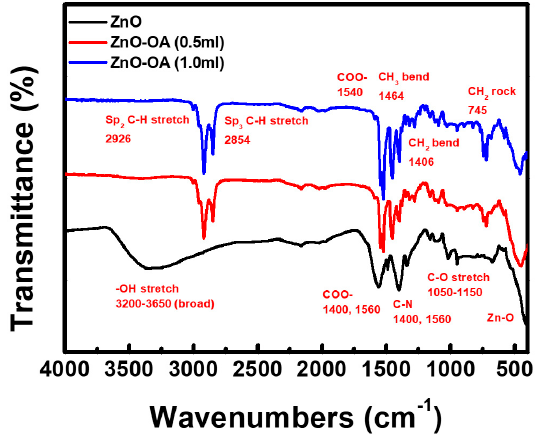
Figure 4. FT − IR spectra of ZnO QDs and ZnO − OA (0.5 mL, 1.0 mL, and 1.5 mL) QDs.